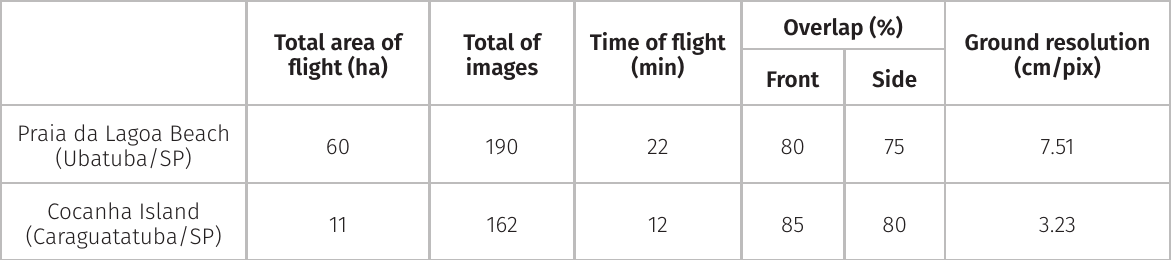
Table I. Flight and processing parameters on October 10, 2020, using a Phantom 4 Advanced. Praia da Lagoa Beach (Ubatuba/SP) Cocanha Island (Caraguatatuba/SP)